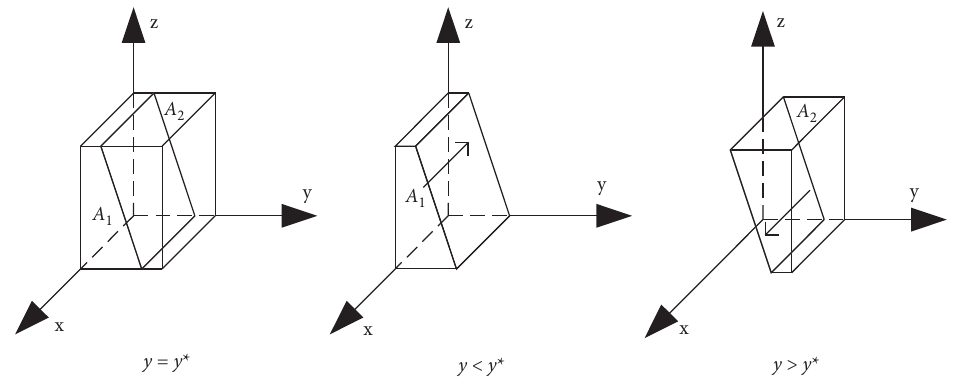
Figure 2: Strategy evolution phase diagram of the private